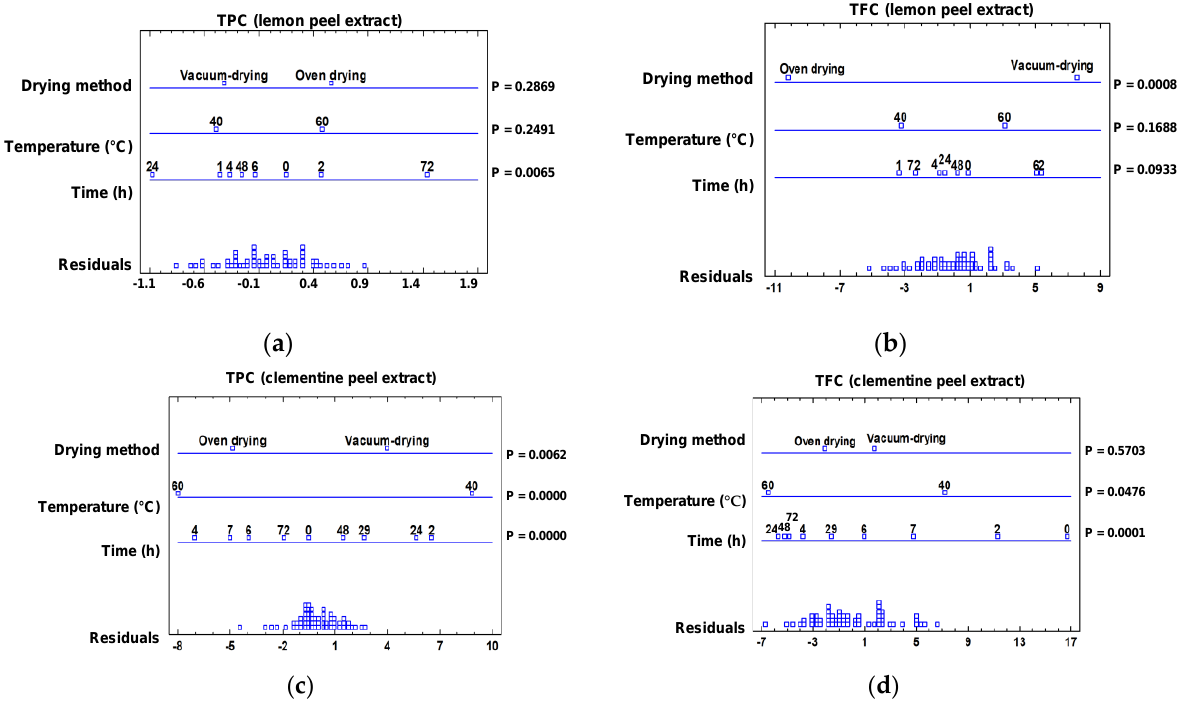
Figure 1. Multifactorial ANOVA plots showing the influence of time, temperature, and extract drying method on: ( a ) TPC in lemon peel extracts, ( b ) TFC in lemon peel extracts, ( c ) TPC in clementine peel extracts, and ( d ) TFC in clementine peel extracts. p − values (P) lower than 0.05 indicate a statistically significant effect at 95% confidence level.